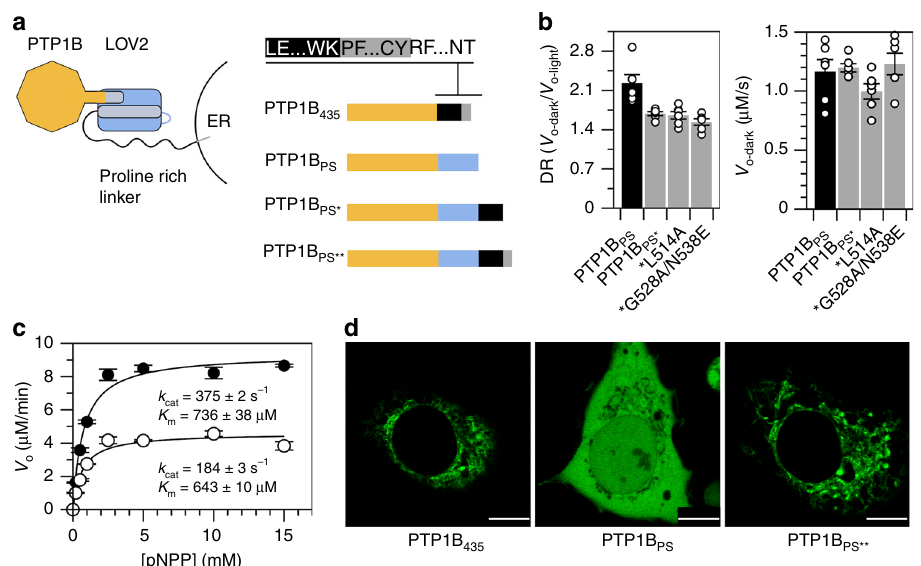
Fig. 3 A natively localized variant of PTP1B PS . a We assembled PTP1B PS* and PTP1B PS** by attaching residues 299 – 405 (the disordered proline-rich region) and 299 – 435 (the proline-rich region and ER anchor), respectively, of full-length PTP1B to the C-terminus of PTP1B PS. Colors correspond to the catalytic domain of PTP1B (orange), the LOV2 domain (blue), the proline-rich region of PTP1B (black), and the ER anchor of PTP1B (gray). b PTP1B PS* is photoswitchable but exhibits a reduced DR, relative to PTP1B PS ; mutations that stabilize the J α helix do not improve DR. The plotted data depict the mean, SE, and associated estimates of DR for n = 6 independent experiments. c Saturation curves show the activity of PTP1B PS* on pNPP ( k cat-dark / k cat-light = 2.03±0.04). Error bars denote SE for n = 3 independent reactions. d Images of COS-7 cells expressing GFP-tagged variants of PTP1B. PTP1B 435 and PTP1B PS** exhibit indistinguishable localization patterns (scale bars appear as a white line over a small black rectangle in the lower right corner of each image; 10 μ m). Source data are provided as a Source Data fi